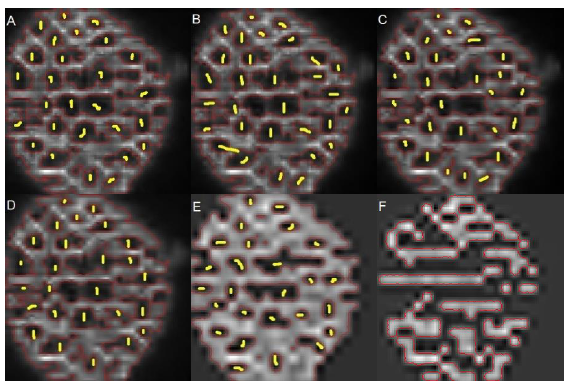
Figure 11. Segmentation results obtained with the level-set technique for four different values of the parameter h . ( A ) h =1. ( B ) h =3. ( C ) h =10. ( D ) h =20. ( E ) h =100. ( F ) h =150.